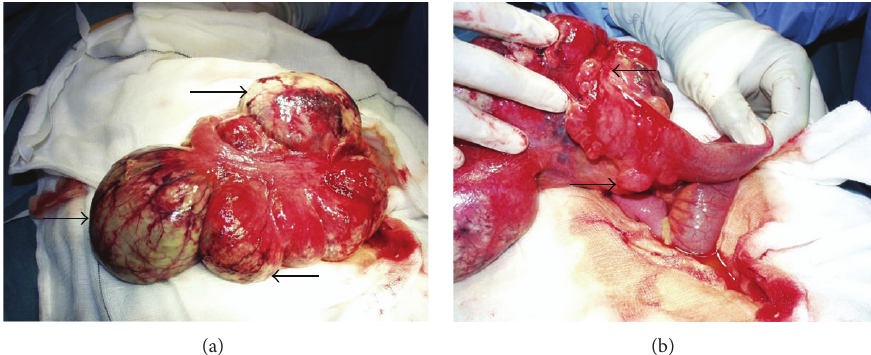
Figure 1: Macroscopic appearance of the ileal diverticula (a) (arrows) and multiple mesenteric cysts (b) (arrows).